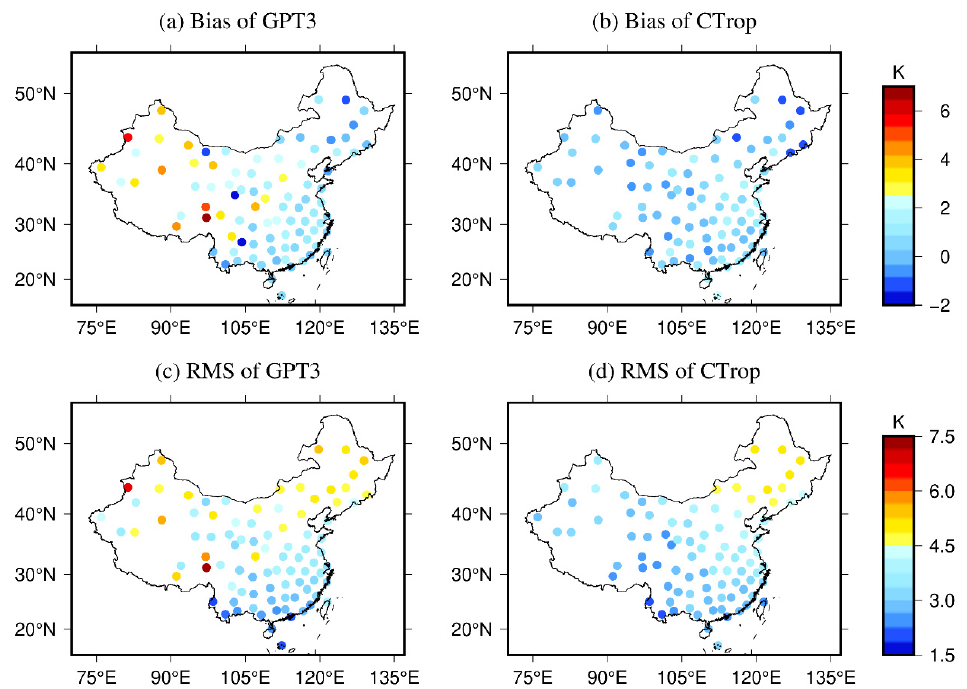
Figure 9. Distribution of the performance of T m at each radiosonde site in 2017 by the CTrop and GPT3 models: ( a ) Bias of GPT3; ( b ) Bias of CTrop; ( c ) RMS of GPT3; ( d ) RMS of CTrop.